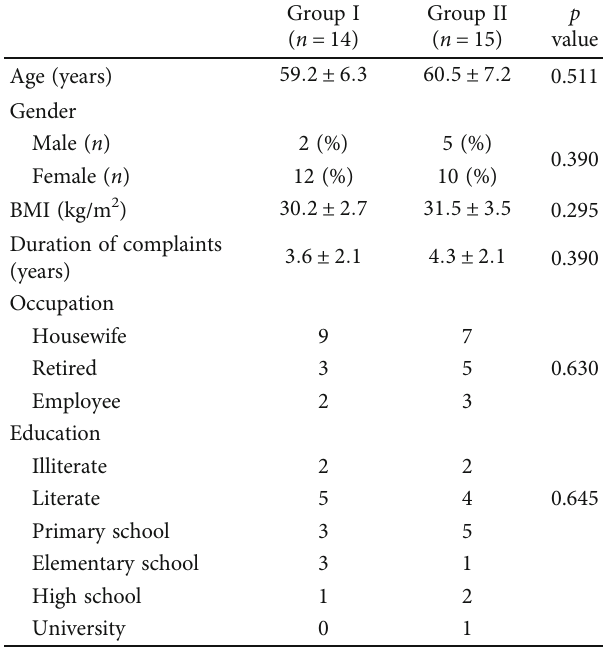
Table 1: Demographic characteristics of